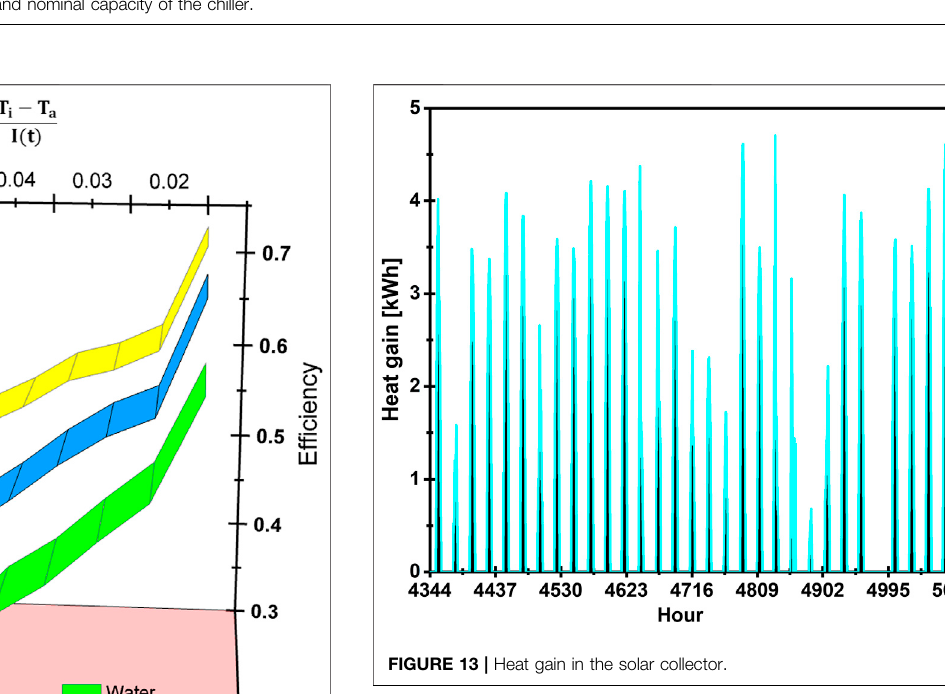
FIGURE 11 | The actual capacity and nominal capacity of the chiller.